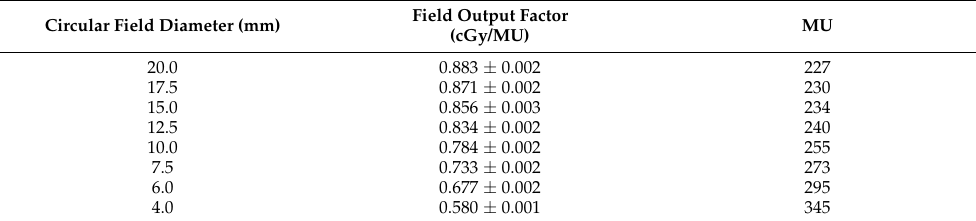
Table 3. Field output factors measured with diamond and SFD